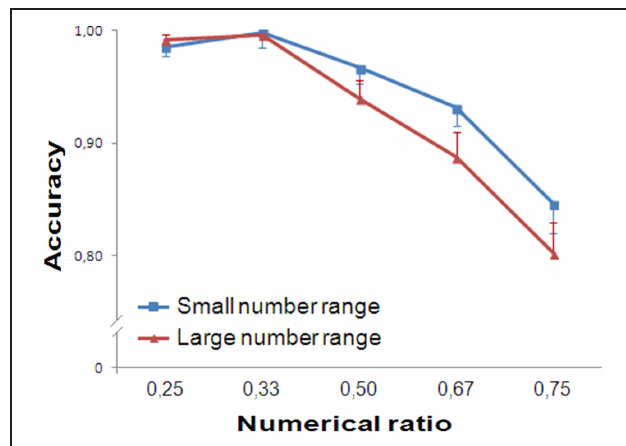
FIGURE 3 | Results of Experiment 2. Accuracy is plotted against the numerical ratio of the contrasts for both small and large number range. The performance of the participants showed ratio dependence for both small and large